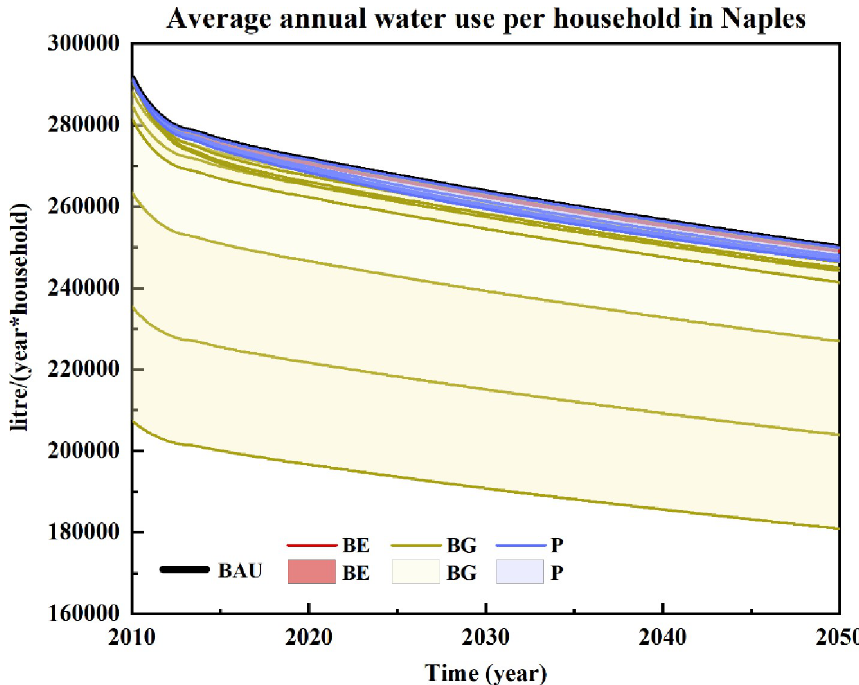
Fig 4. Scenarios of average annual household water use in the metropolitan city of Naples for the years 2010– 2050. Included scenarios: Business as usual (BAU), Price-based policies (P), Behavioural education actions (BE), and Behavioural guidance actions